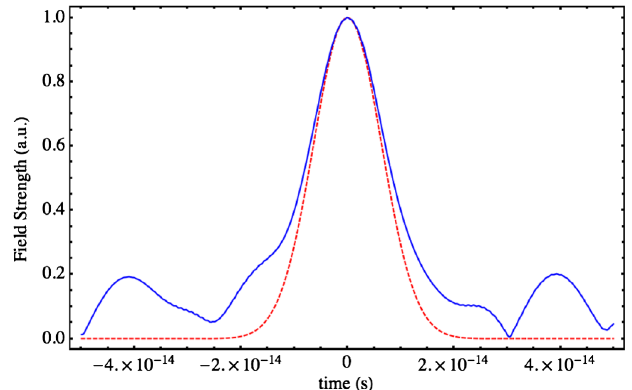
FIG. 10. Bunch profile generated using the results from the X- FROG retrieval algorithm and inverting Eq. (12). The original 15 fs bunch profile is shown in red and the retrieved pulse is given in blue. Both curves are normalized for direct comparison. The modulations at the wings of the retrieved pulse are due to the resonance generated in the second order